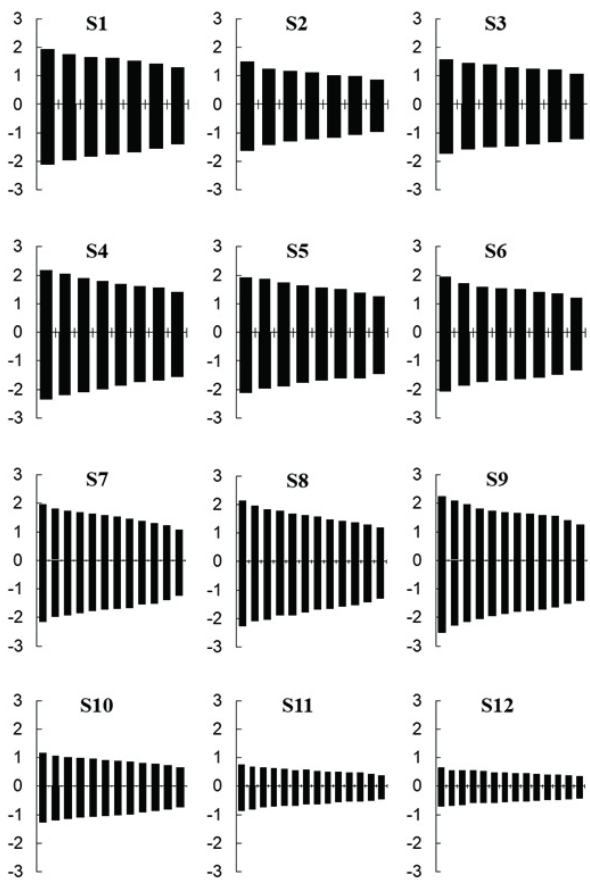
Figure 3. Idiograms of haploid chromosomes of 12 berry species.